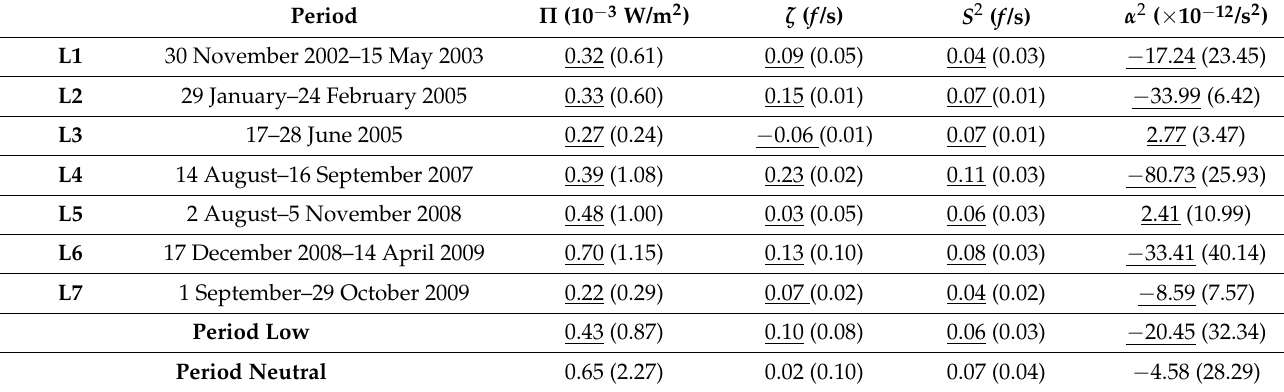
Table 2. Same as Table 1 but during period